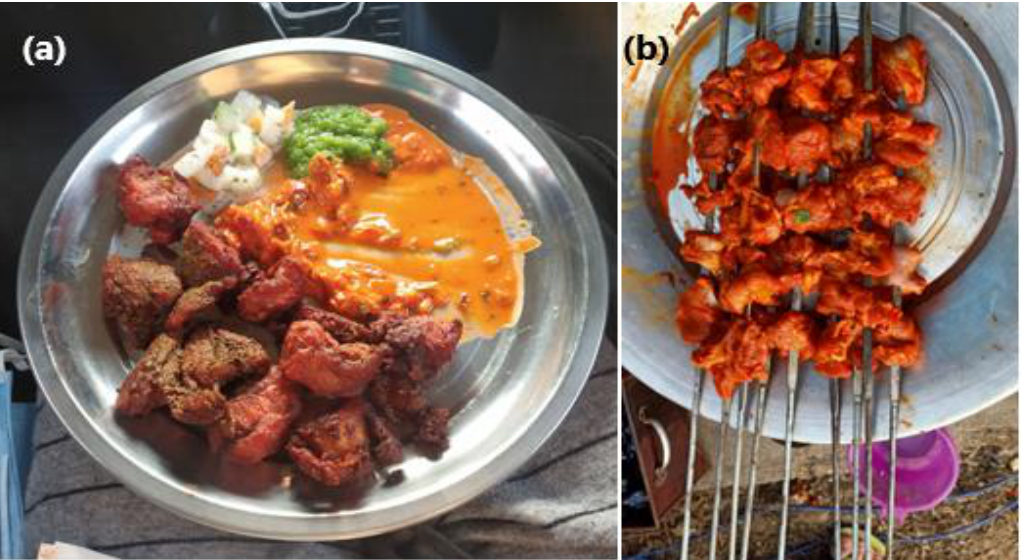
Figure 4. ( a ) Barbeque presented in lavish style at the famous Makai Park. ( b ) Barbeque prepared at